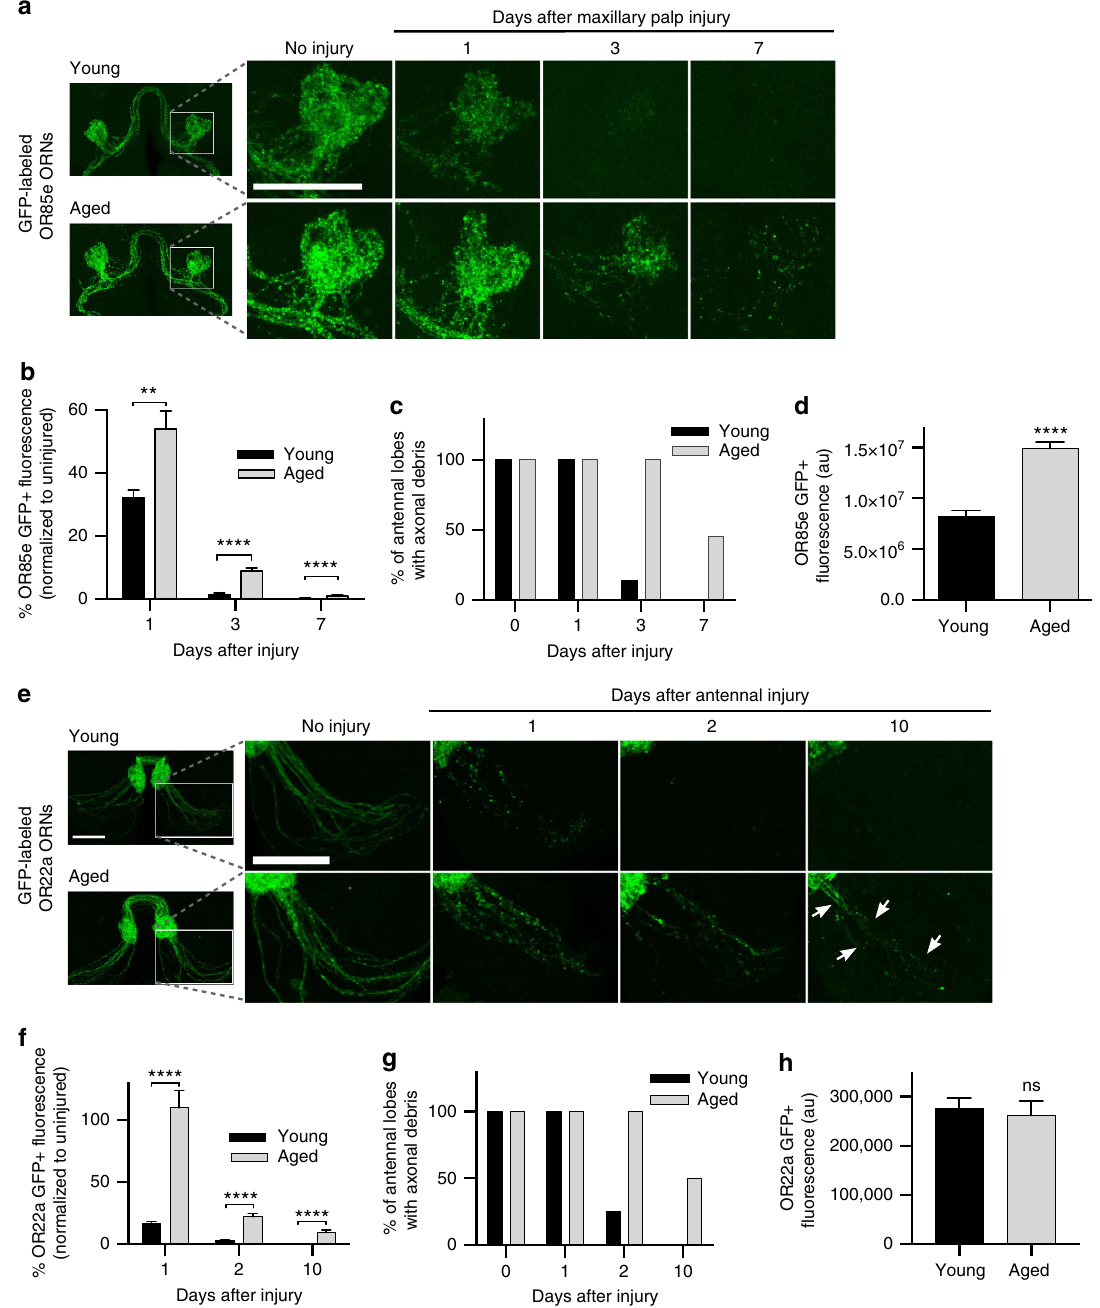
Figure 1 | Aged glia fail to efficiently clear degenerating axons in the adult Drosophila brain. ( a ) GFP-labelled maxillary ORN axons before and after maxillary nerve axotomy in young and aged flies. Zoomed images show OR85e-innervated glomeruli. ( b ) Quantification of GFP þ debris in OR85e glomeruli; mean ± s.e.m. plotted; ** P o 0.01 and **** P o 0.0001, Mann–Whitney post-hoc test. ( c ) Percentage of antennal lobes containing visible GFP þ OR85e debris after maxillary nerve axotomy. ( d ) Total GFP fluorescence in OR85e glomeruli; mean ± s.e.m. plotted; **** P o 0.0001, unpaired t -test. ( e ) GFP-labelled antennal ORN axon projections before and after antennal nerve axotomy in young and aged flies. GFP þ axonal material was still present in aged brains 10 days after antennal nerve injury (white arrows). ( f ) Quantification of OR22a axonal debris in e ; mean ± s.e.m. plotted; **** P o 0.0001, Mann–Whitney post-hoc test. ( g ) Percentage of antennal lobes containing visible tracts of antennal GFP þ axons. ( h ) Total GFP fluorescence of OR22a axons; mean ± s.e.m. plotted; NS, not significant, unpaired t -test. N Z 20. Scale bar, 30 m m. Representative confocal Z -stacks shown for all panels in a and e . Genotypes: a – d : w 1118 ;OR85e-mCD8::GFP/ þ ; e – h : w 1118 ;OR22a-Gal4, UAS mCD8::GFP/ þ